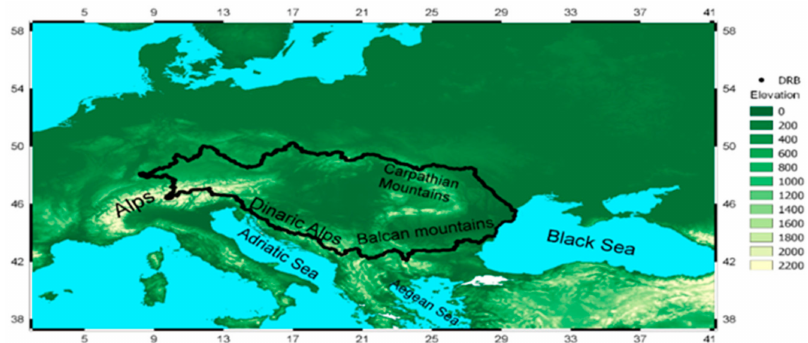
Figure 1. The black contour line indicates the Danube river basin (DRB) area. In colors is indicated the elevation of the region (units in meters). Data from the Hydrosheds project (Available online: